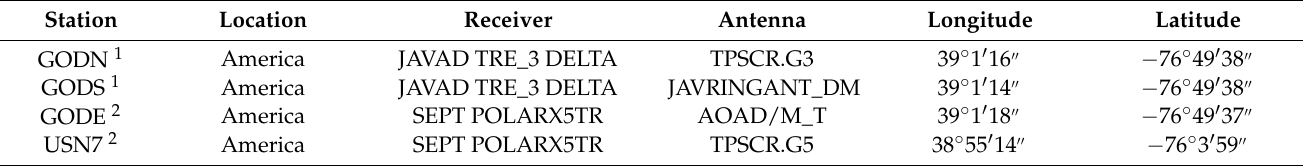
Table 2. Information of experimental datasets for all the